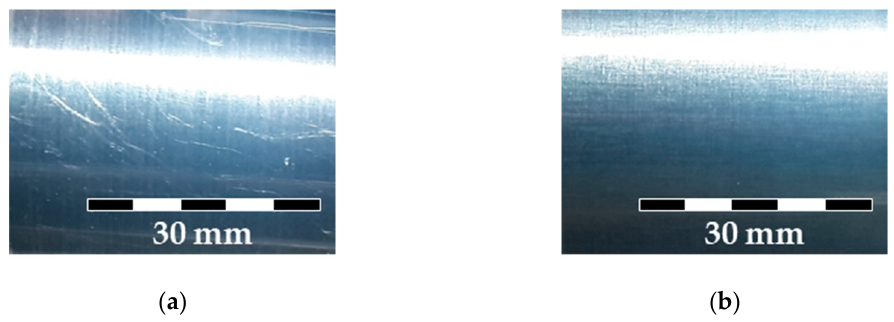
Figure 13. Machined surfaces produced by inserts: ( a ) Without chip breaker, where uncontrolled chips scratched the newly machined surface; ( b ) with chip breaker, where chips were properly removed from the cutting zone and good quality finishing is preserved.